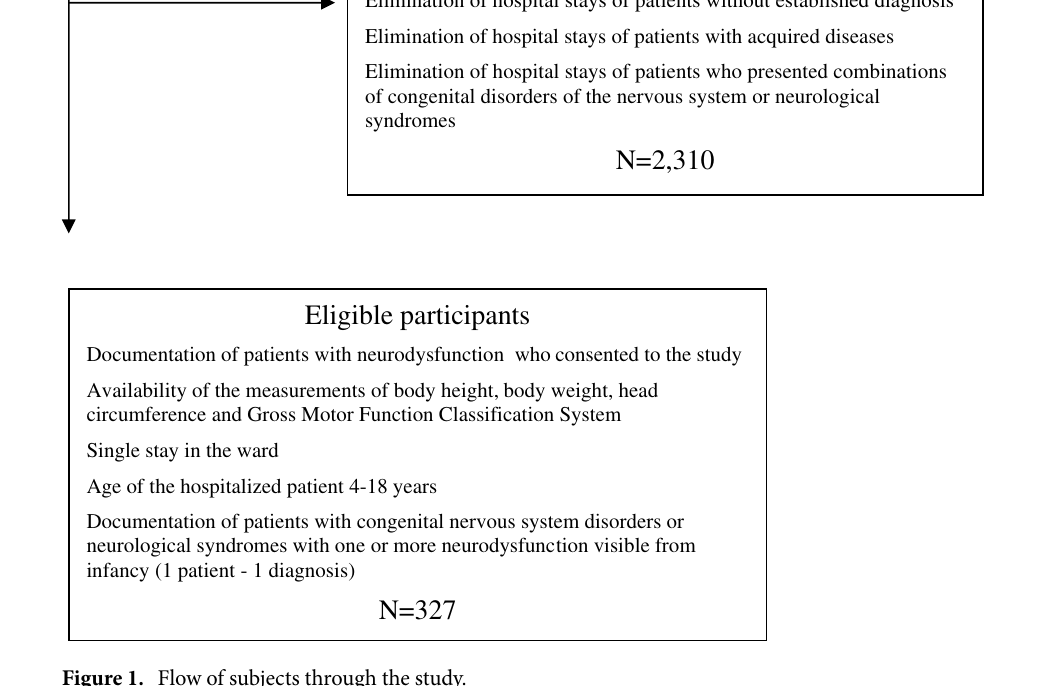
Figure 1. Flow of subjects through the